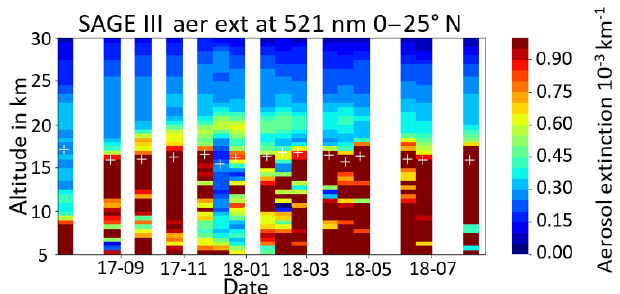
Figure C1. Same as for Fig. 1d but considering all measurements from 0 to 25 ◦